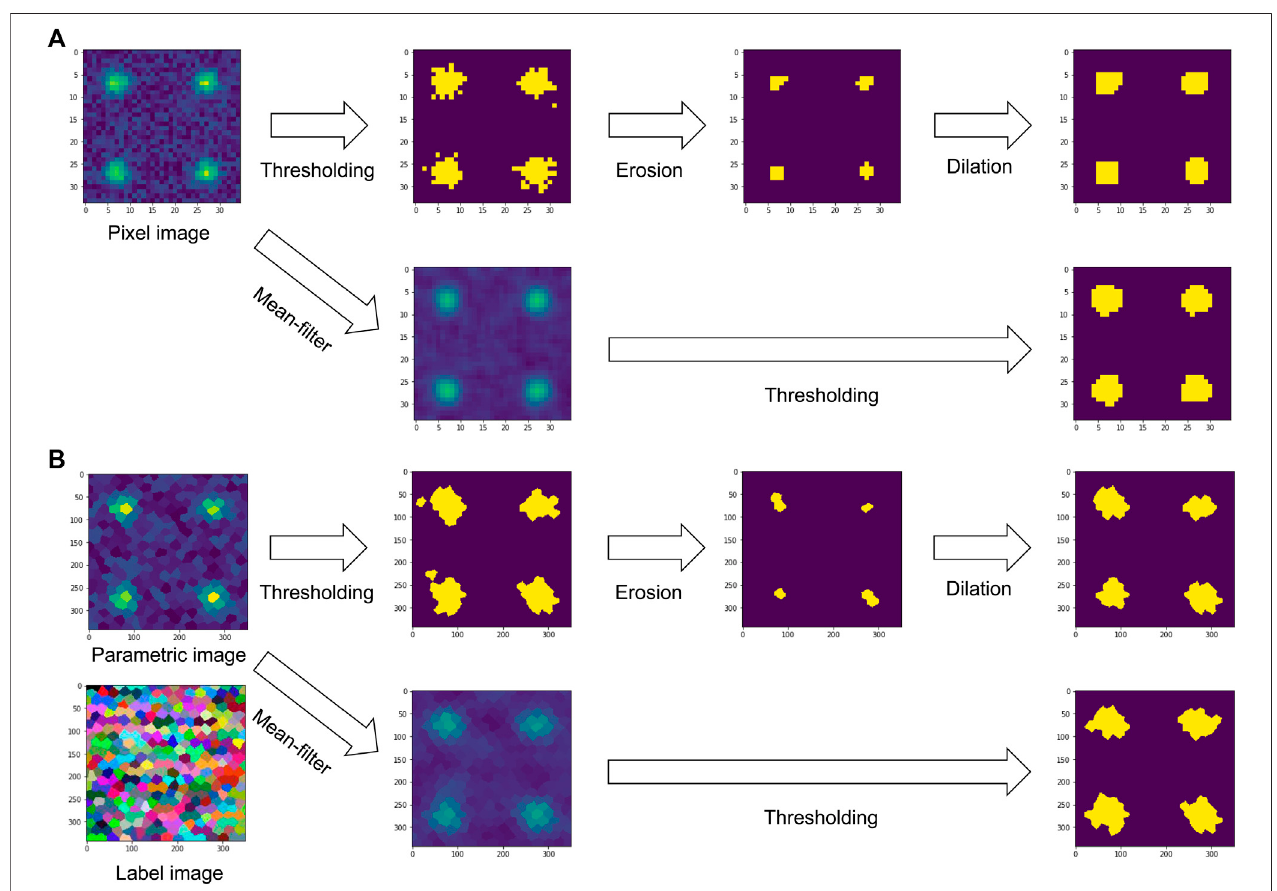
FIGURE2 | Comparison between fi lters for binarizing an image on agrid ofpixels (A) and a grid of cells (B) . Both canbe used analogously: When applying amean average fi lteron apixel-grid,theintensitiesofneighboringpixelsareaveraged. Incaseofacell-grid,intensitiesofcellsinagivenparametricimage areaveraged locallyto make a new parametric image. The associated label image serves as representation of the region adjacency graph of the cells. Binary image processing fi lters such as erosion and dilation work analogously, also on the same region adjacency graph expressing neighborhood relationships between cells.